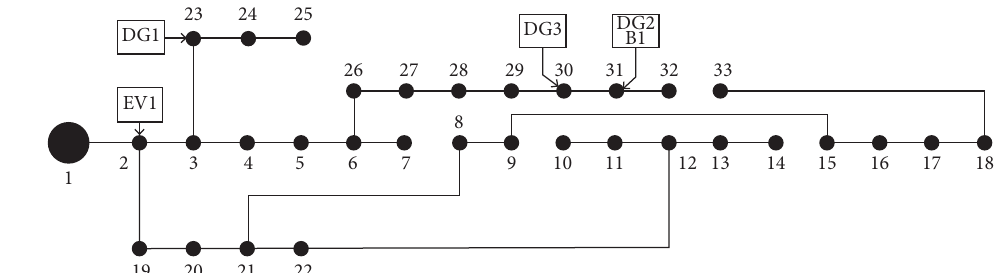
Figure 4: Topology 2 of IEEE 33 bus system.